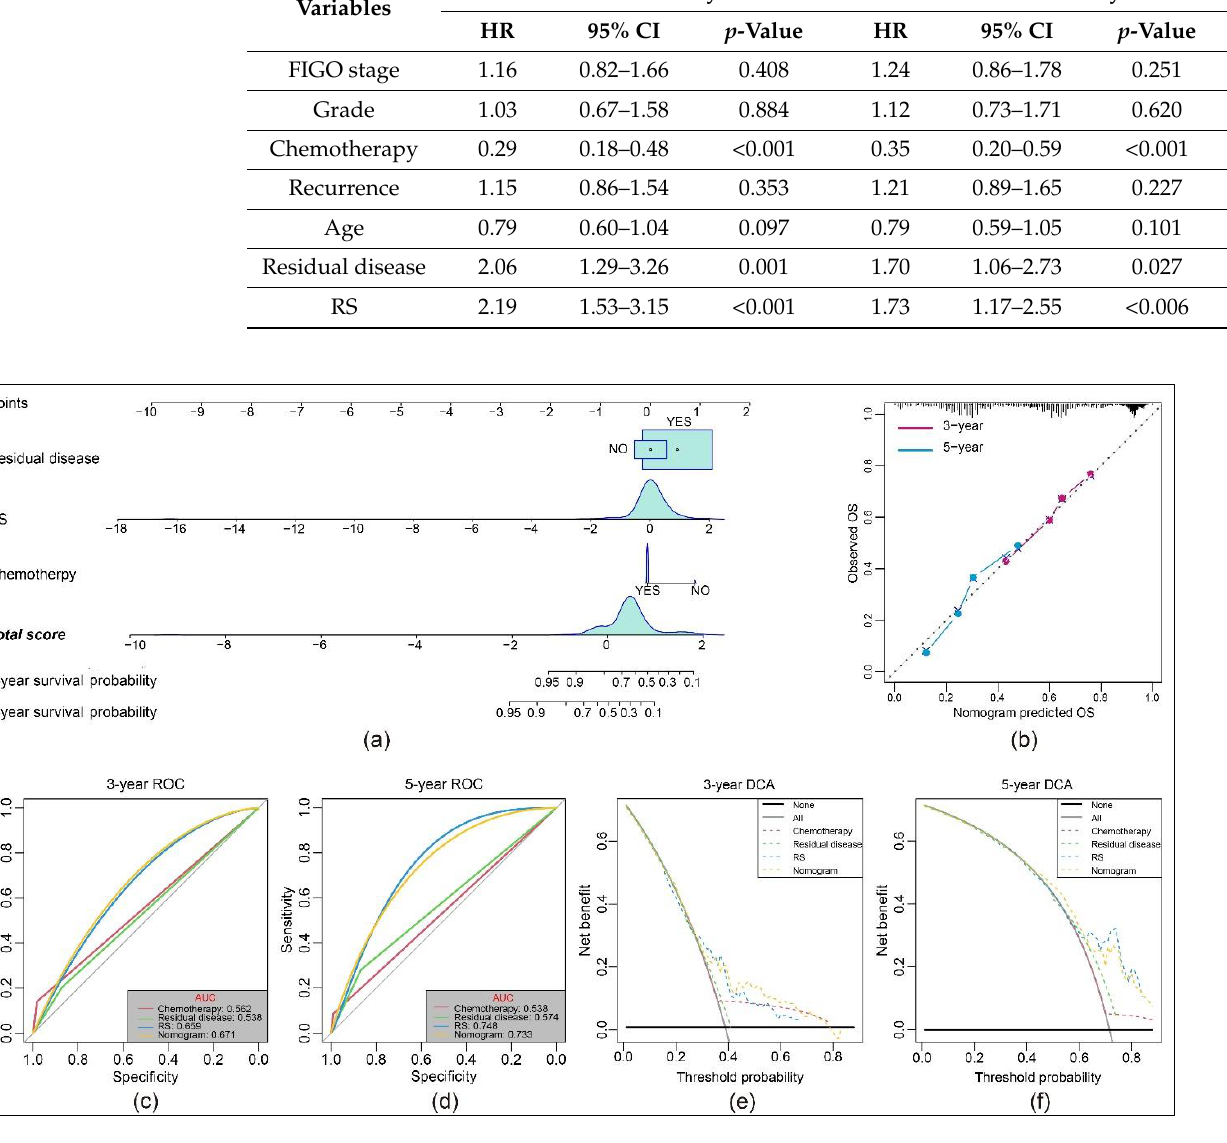
Figure 4. Clinical value of the predictive model: ( a ) Nomogram predicting the 3- and 5-year OS for patients. The points identified on the point scale of each variable are totaled. Finally, beneath the total points, the probability of 3- or 5-year survival is projected on the scales below. ( b ) Calibration curves for the nomogram predicted 3- and 5-year OS for patients in relation to actual survival. ( c , d ) ROC curves of the nomograms compared with other clinical variables. ( e , f ) Decision curve analysis (DCA) curves can evaluate the clinical benefit of the nomograms and their potential scope of application. Black indicates that all samples are negative and none are treated, therefore the net benefit is zero. Gray indicates that all samples are positive and all are treated. The x-axis represents the threshold